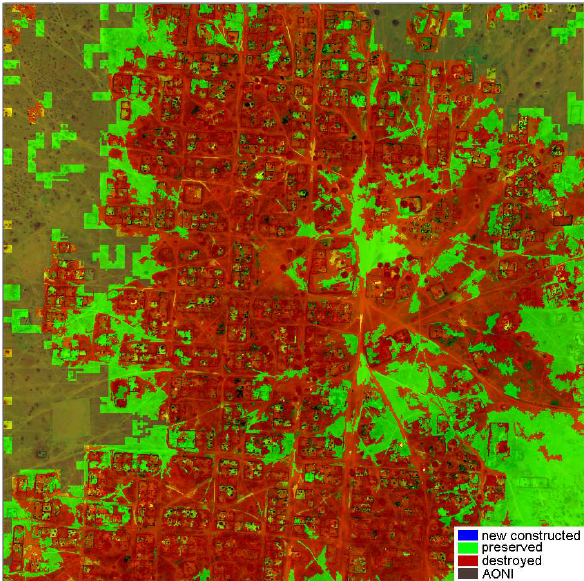
Figure 7. Results of the Change Detection Analysis for the village